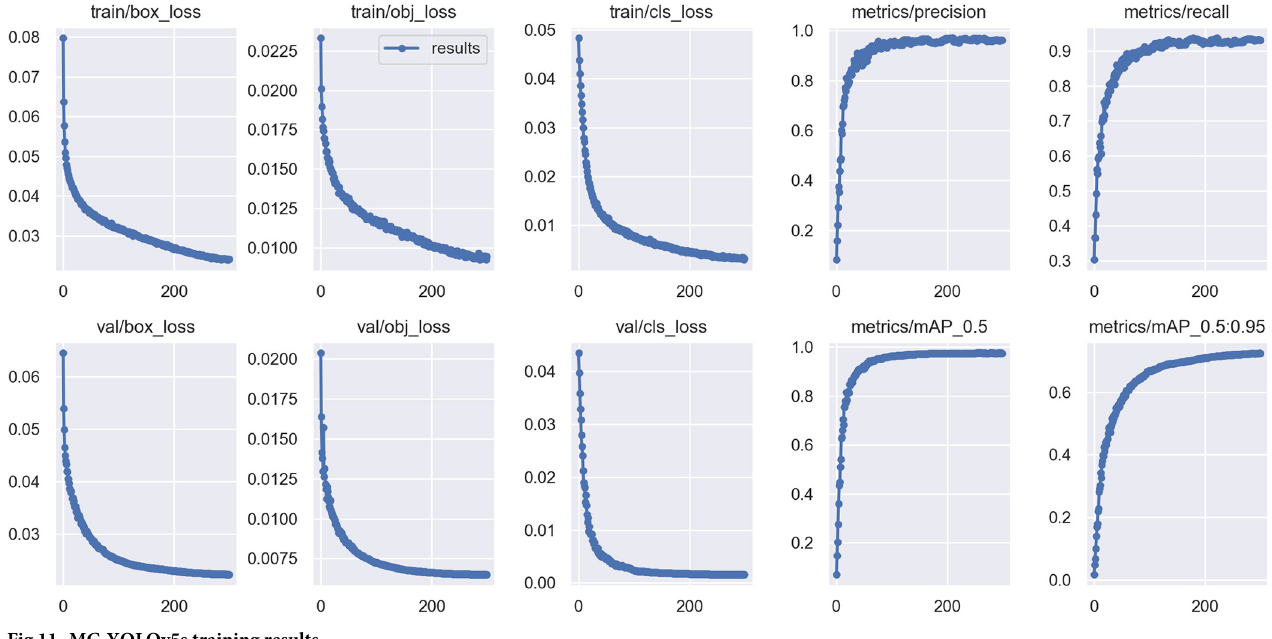
Fig 11. MC-YOLOv5s training results.